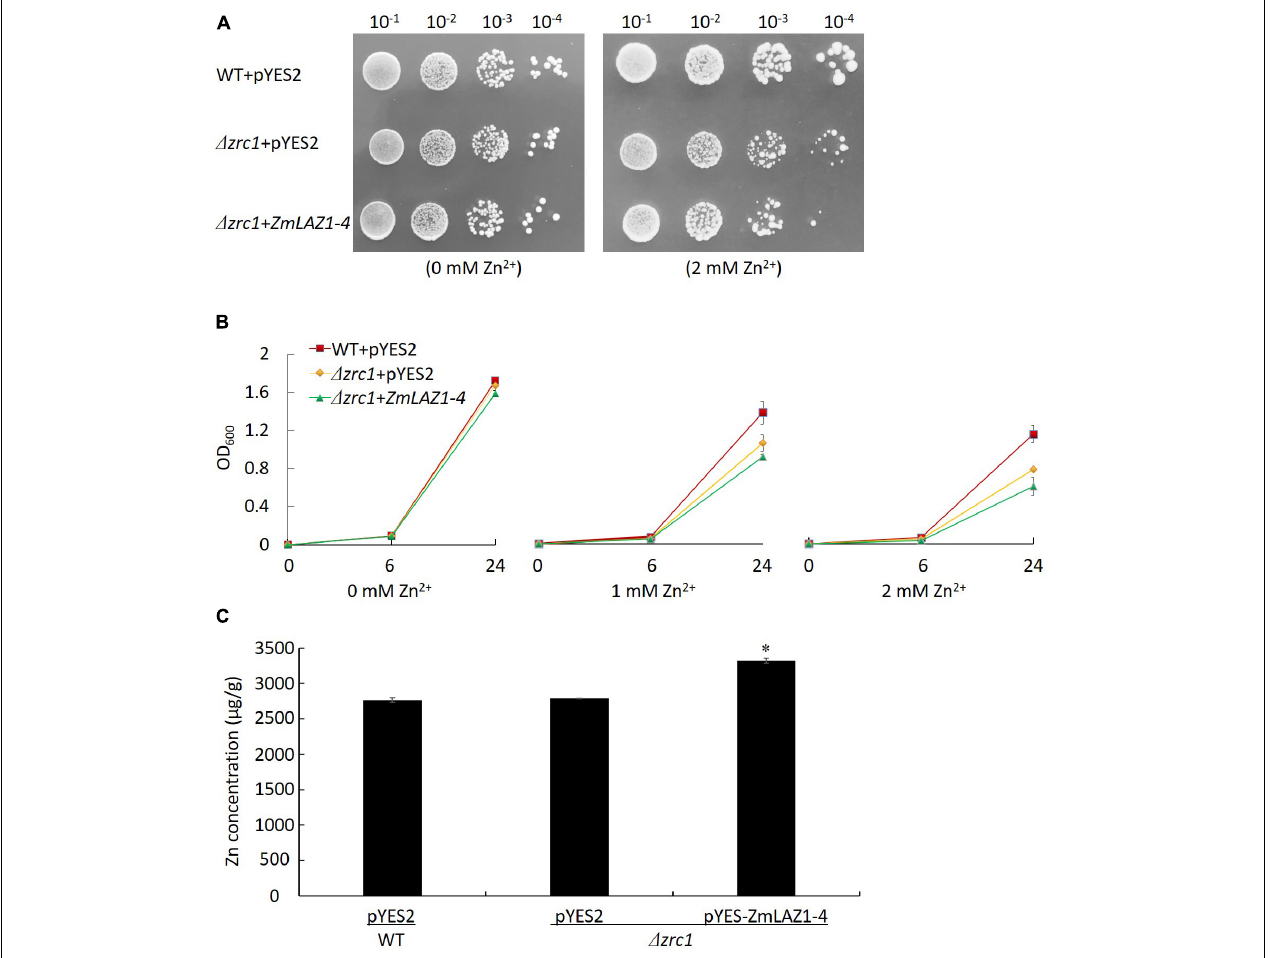
FIGURE 2 | Zinc transport assay in yeast Zn-sensitive mutant. (A) Colonies of WT and (cid:49) zrc1 mutant transformed by empty vector and (cid:49) zrc1 transformed by ZmLA1-4 under 0 and 2 mM ZnSO 4 stress. (B) OD 600 curves of the three lines under 0, 1, and 2 mM ZnSO 4 stress. (C) Zn concentration in yeast grown in synthetic dropout medium (SD) with 2 mM ZnSO 4 for 48 h. ∗ p <